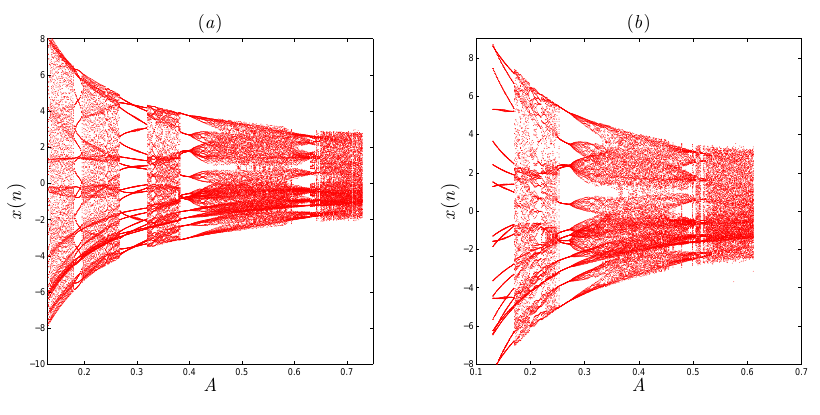
Figure 4. ( a ) The bifurcation diagram versus B , when A = 0.7 and γ = 0.95. ( b ) The LLE in accordance with diagram ( a ).